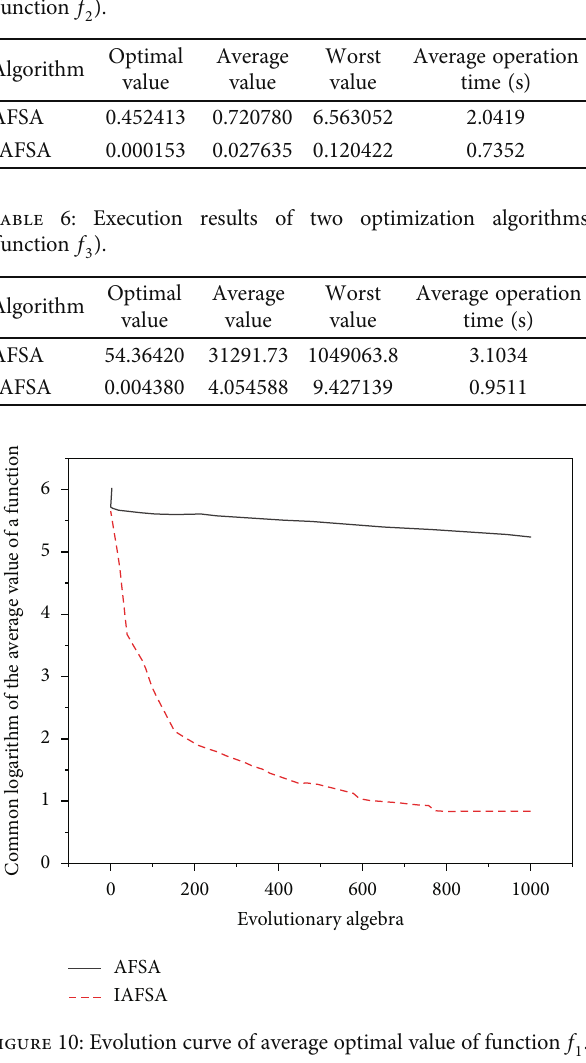
Table 5: Execution results of two optimization algorithms (function f 2 ).